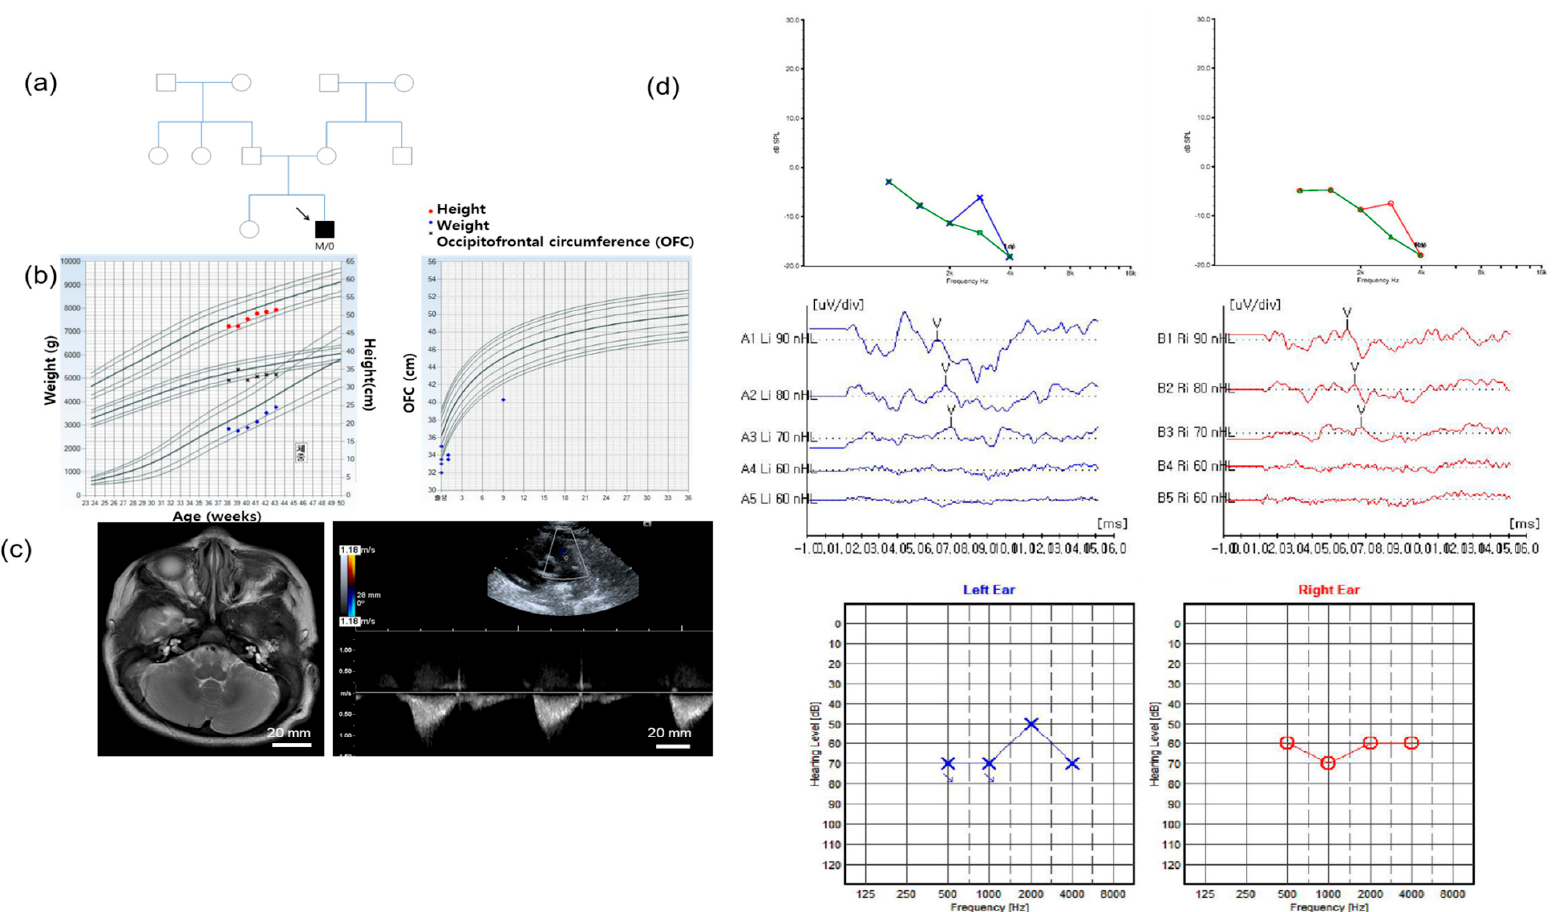
Figure 1. Auditory evaluations, imaging studies, and pedigree of the proband. ( a ) The proband was the only affected individual in the family; ( b ) The growth parameter of weight, height, and occipitofrontal circumference of the proband; ( c ) Brain MRI showed normal inner ear morphology and no evidence of other brain anomalies. Echocardiogram showed abnormal and echogenic density in the pulmonary artery area and tricuspid valve insufficiency; ( d ) Distortion product otoacoustic emission (DPOAE), auditory brainstem response (ABR) thresholds, and auditory steady state response (ASSR) tests demonstrated hearing loss of the proband (red line, o = right ear, blue line, x = left ear).